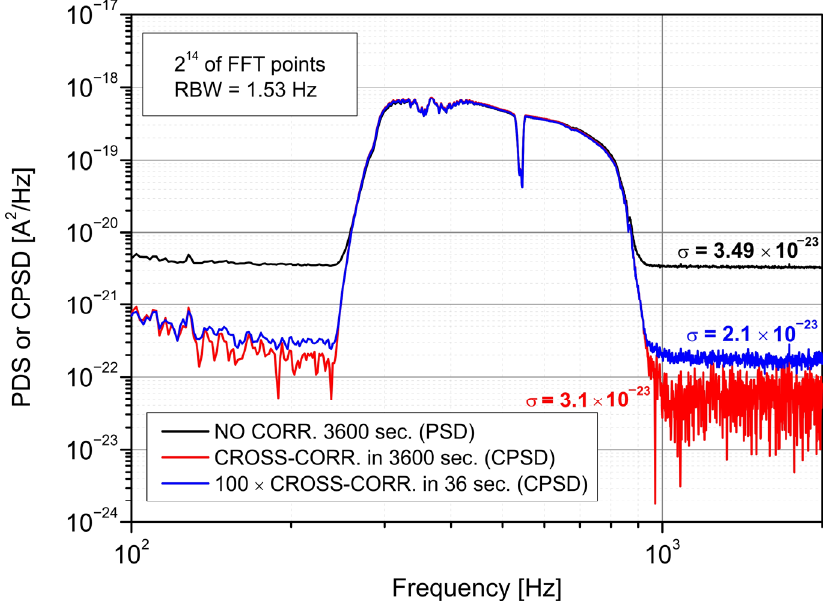
Figure 9. The spectra after cross-spectra averaging.